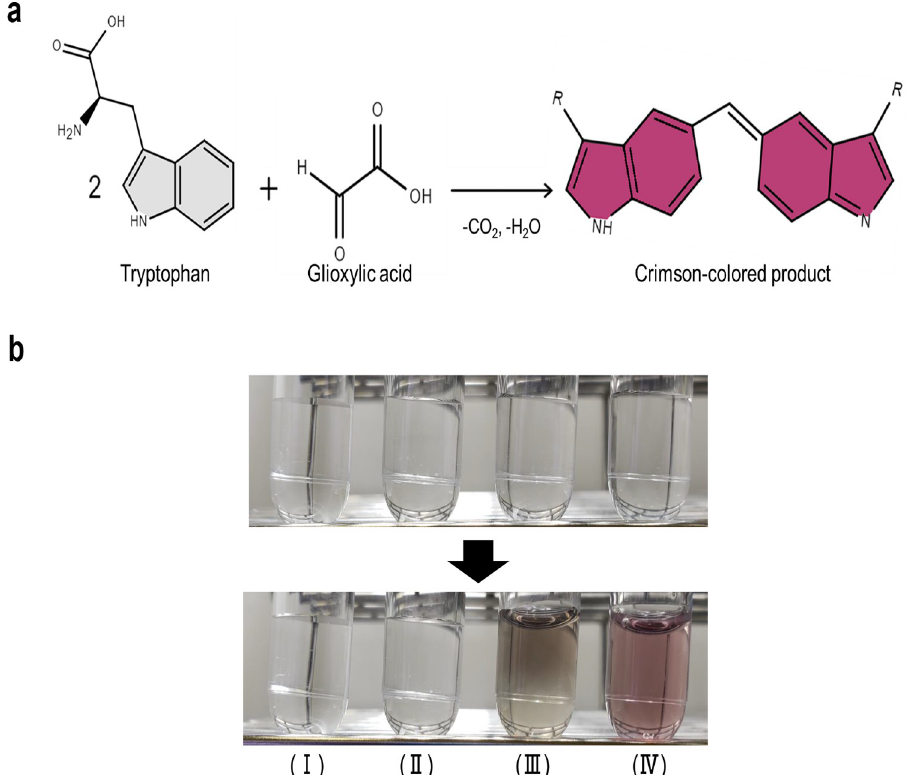
Fig 1. Color reaction of Trp by oxidative condensation with aldehydes. (a) Schematic illustration of Trp coloring reaction with aldehyde based on the Hopkins-Cole reaction. (b) Color reaction of Trp with different reaction solutions: (I) reagent blank (0 mg/L of Trp with 200 g/L of glyoxylic acid monohydrate, 10% HCl, and 3% NaOCl � 5H 2 O), (II) 100 mg/L of Trp with 200 g/L of glyoxylic acid monohydrate and 10% HCl, (III) 100 mg/L of Trp with 10% HCl and 3% NaOCl � 5H 2 O, and (IV) 100 mg/L of Trp with 200 g/L of glyoxylic acid monohydrate, 10% HCl, and 3% NaOCl � 5H 2 O.